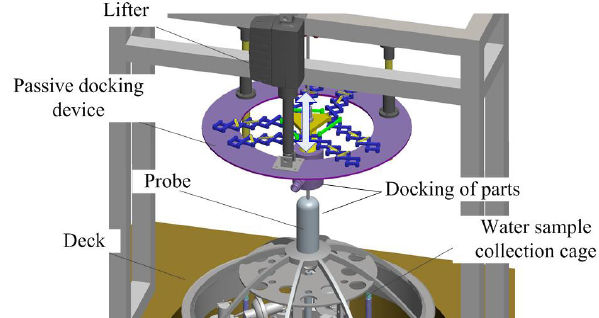
Figure 23. Passive docking device.